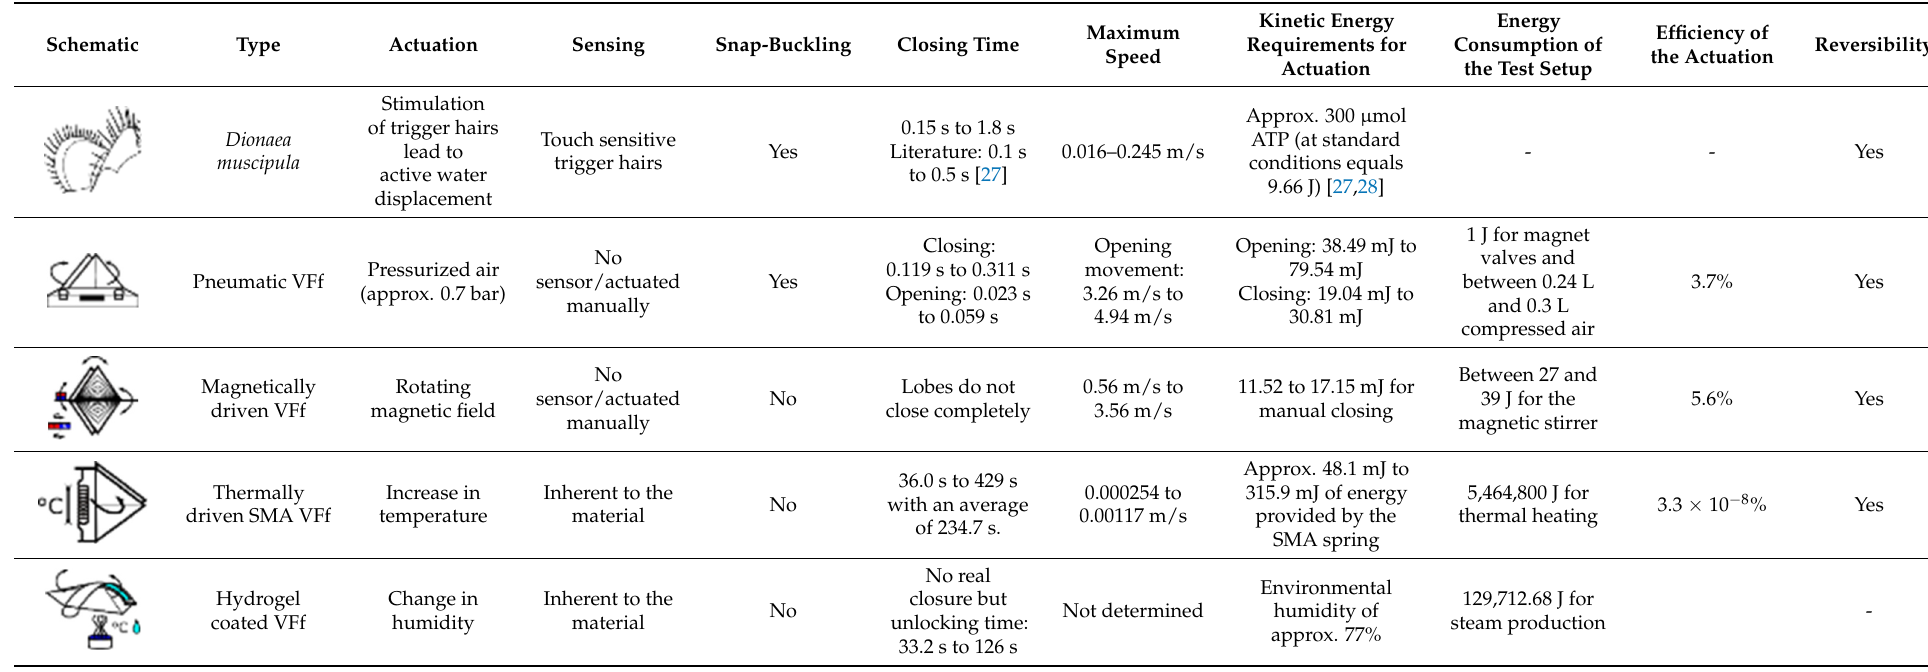
Table 1. Comparison of D. muscipula with artificial Venus flytraps. Schematic